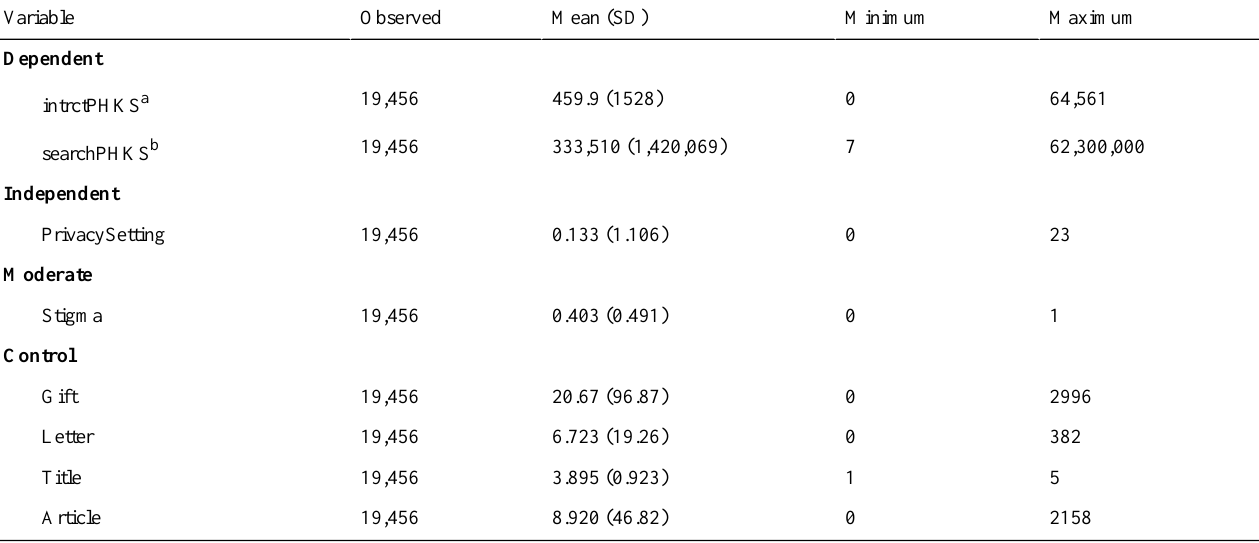
Table 2. Descriptive statistics for selected variables.